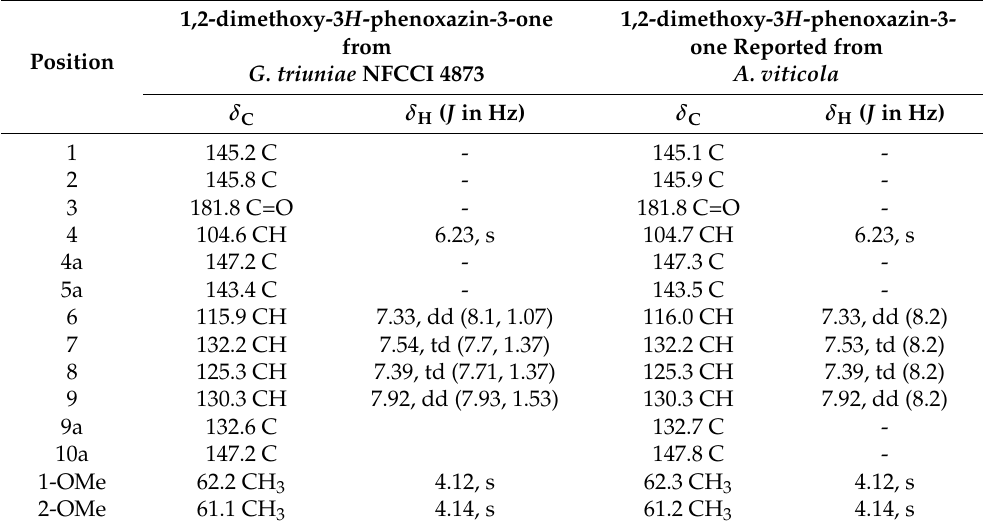
Table 3. The 1 H NMR (500 MHz, CDCl 3 ) and 13 C NMR (125 MHz, CDCl 3 ) spectroscopic data for 1,2-dimethoxy-3 H -phenoxazin-3-one isolated from G. triuniae NFCCI 4873 along with the reported one